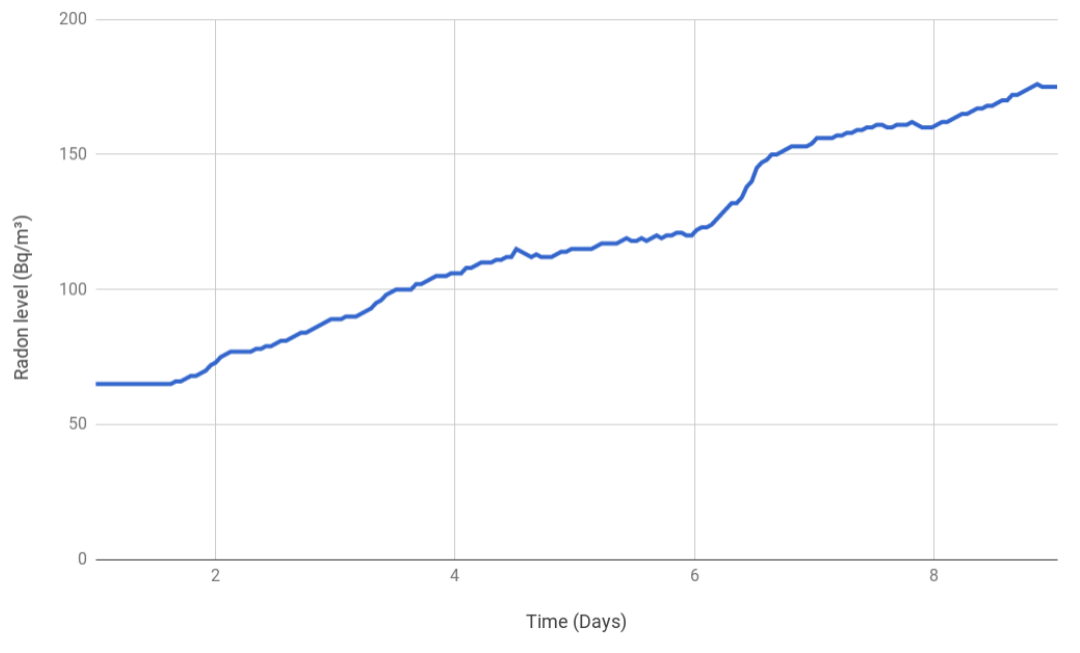
Figure 12. Radon gas concentration in a rural home.